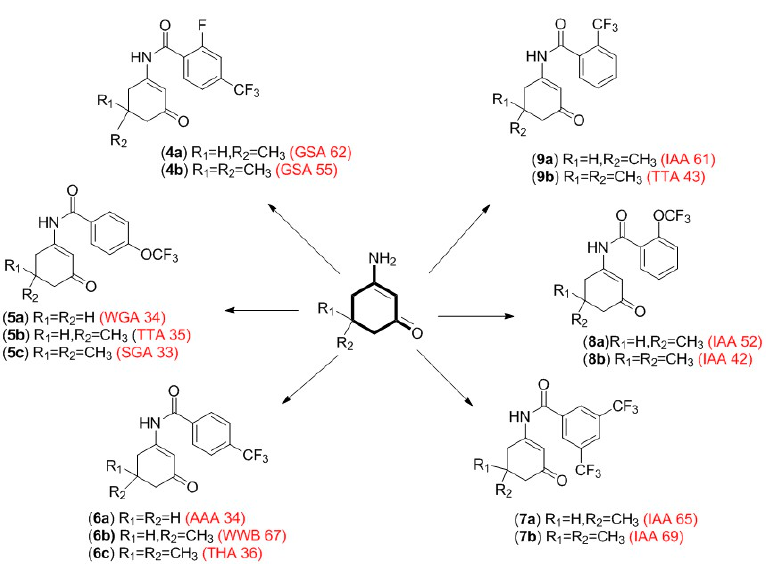
Figure 3. Library of fluorinated N-Benzamide enaminones. The 14 novel fluorinated N-benzamide enaminones were synthesized in moderate to good yield. enaminones were synthesized in moderate to good